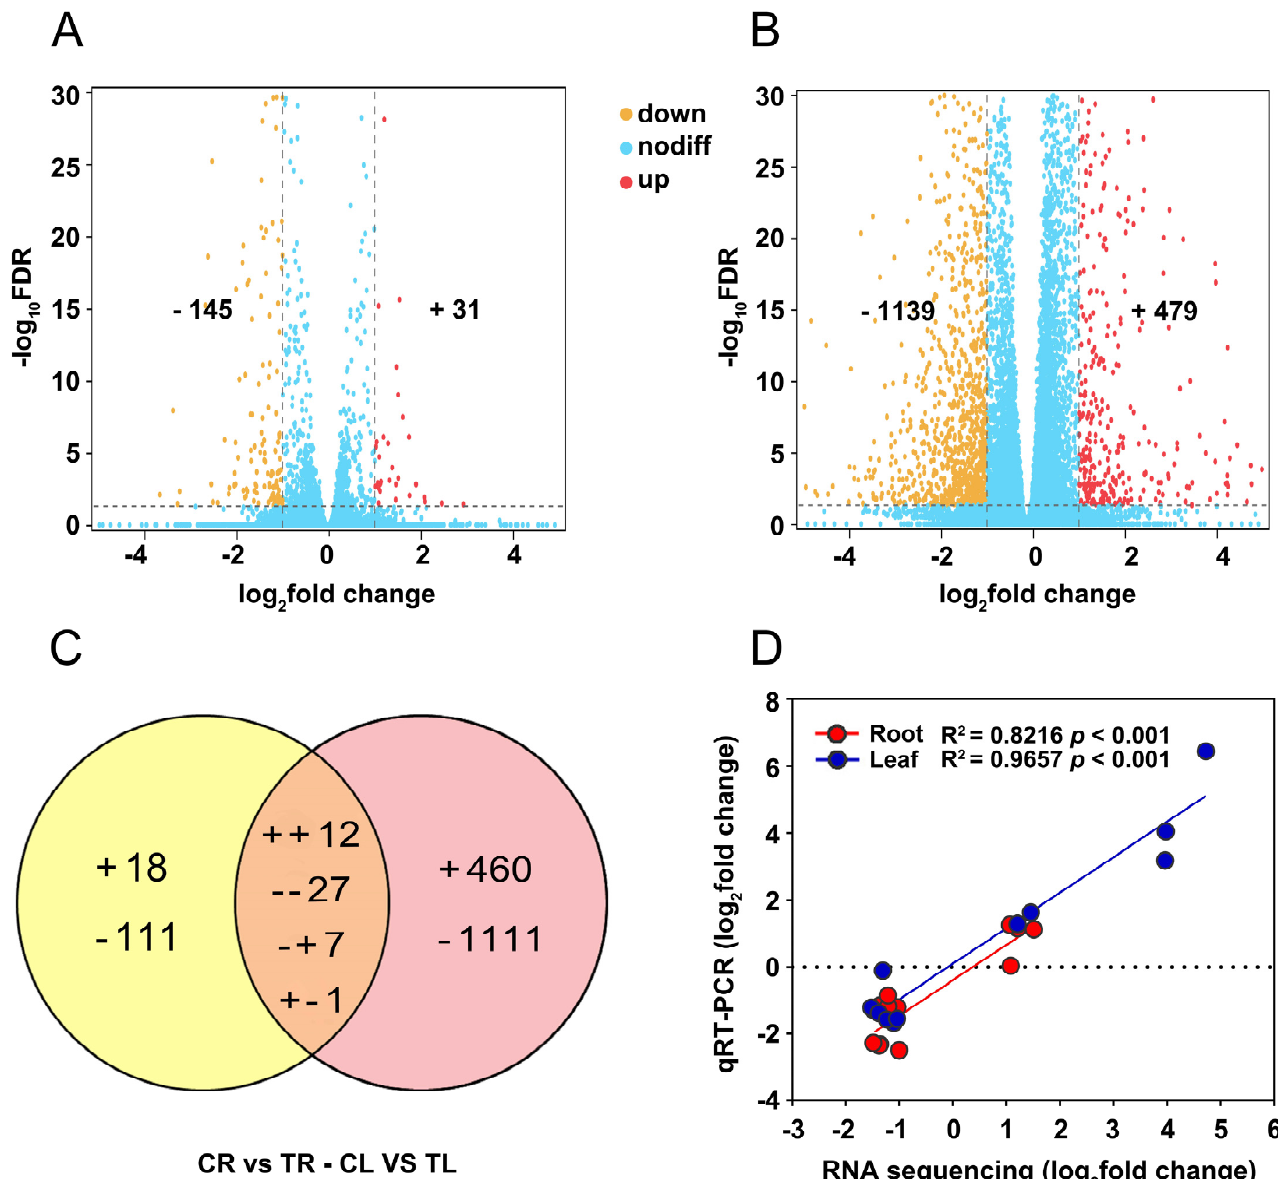
Figure 3. Differentially expressed genes (DEGs) in roots and leaves of C. gigantea and qRT-PCR validation. ( A ) Volcano plot of DEGs in in roots. ( B ) Volcano plot of DEGs in leaves. ( C ) Venn diagrams showing the unique and shared regulated genes in roots and leaves under Cd stress. (+, upregulated; -, downregulated). ( D ) Linear regression analysis of change folds for the 12 selected genes between RNA sequencing and qRT-PCR results in roots and leaves.